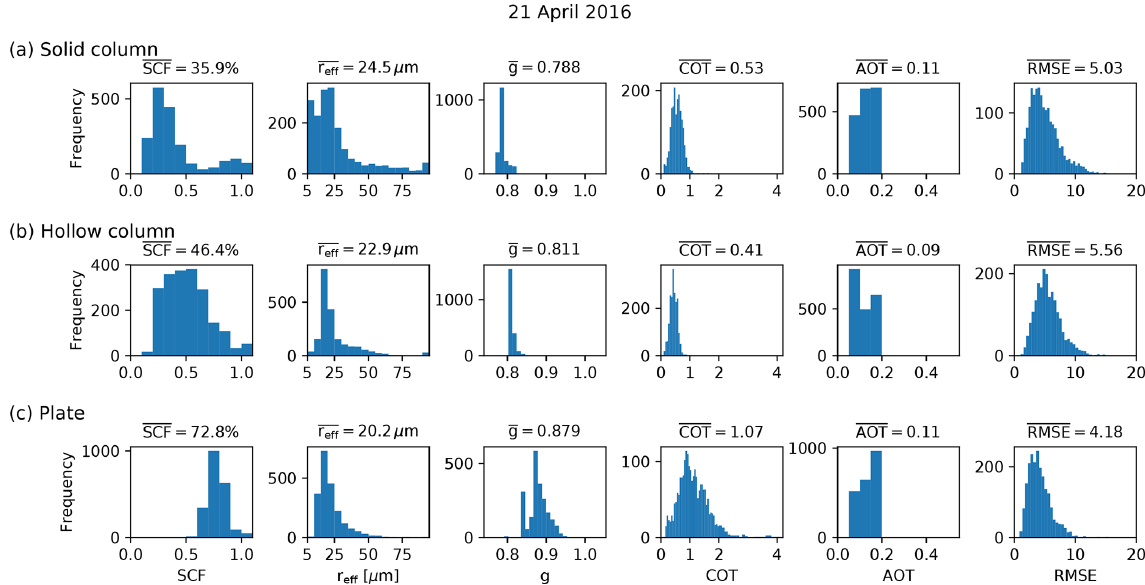
Figure 5. Retrieval results for 21 April 2016 for three selected YG13 ice crystal shapes: (a) solid columns, (b) hollow columns, and (c) plates. The different panels show histograms of the best-matching LUT parameters for the SCF, effective radius ( r eff ), asymmetry factor ( g ), cirrus optical thickness (COT), aerosol optical thickness (AOT), and RMSE between LUT and measurement (from left to right). The results were filtered for a halo ratio HR > 1 to ensure that only image slices with a 22 ◦ halo were analyzed, and the uppermost image segment (no. 3; cf. Fig. 4) was excluded from the analysis to avoid applying the retrieval to upper tangent arcs.